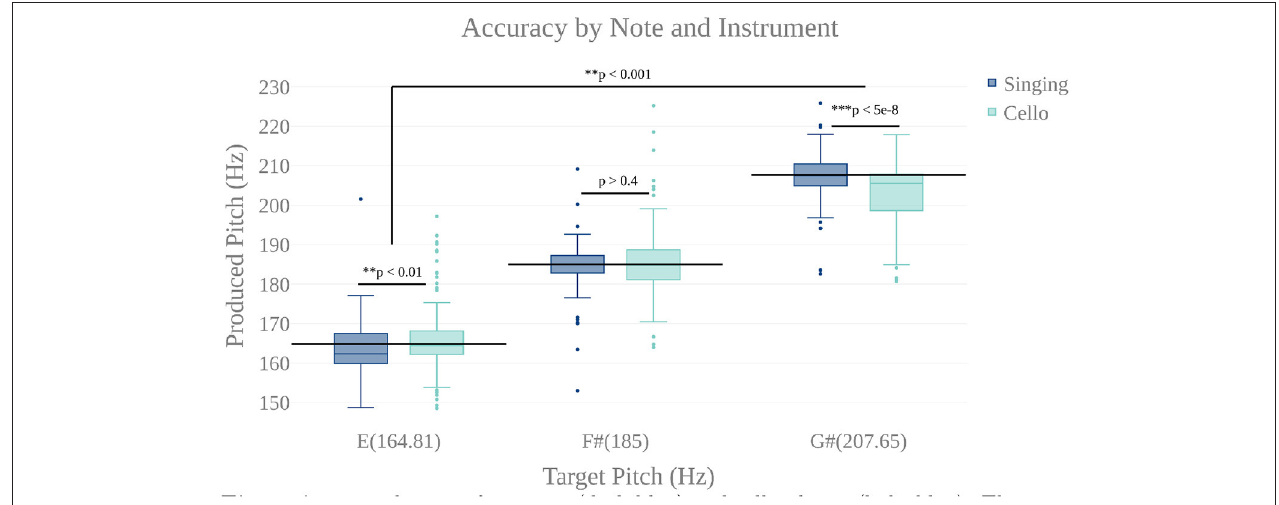
FIGURE 6 | Accuracy by note for singing (dark blue) and cello playing (light blue). There is a highly significant main effect of note, but no main effect of instrument. There is a significant note by instrument interaction showing that participants were slightly flat on the lowest note when singing and slightly flat on the highest when playing the cello. However, mean produced tones were within a quarter tone accuracy (50